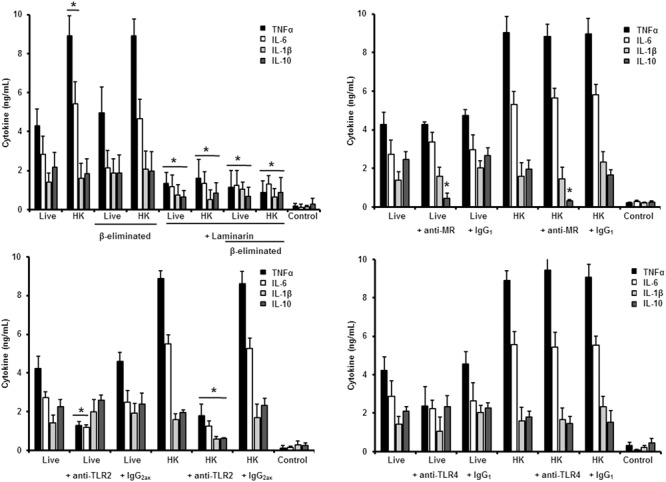
Cytokine production by human PBMCs stimulated with S. schenckii sensu stricto yeast-like cells. As Figure 3, but yeast-like cells were used. ∗P < 0.05, when compared with untreated cells.